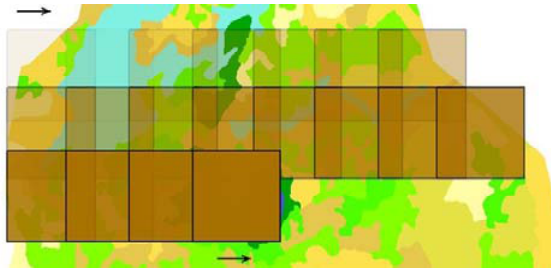
Fig. 1. Principle scheme of sample area “striding” across the chosen natural type of landscape The process of programmed striding included deli- neation of square shaped 2.5 km 2 area in each of the men- tioned almost 68 thousand locations. These provisional areas created by “striding” can be called pseudo-sample areas or pseudo samples, emphasizing their transitional and temporary purpose.